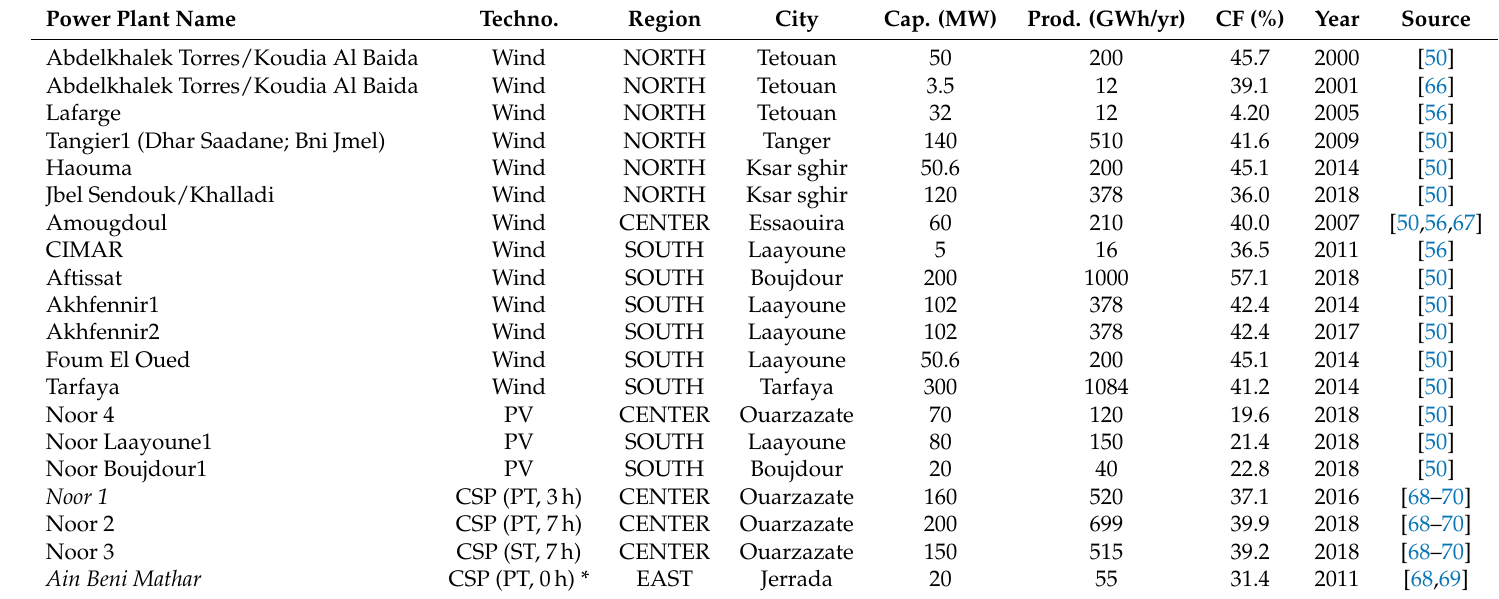
Table A4. Characteristics of the wind, PV and CSP plants from Morocco operational in 2018. PT: Parabolic Trough CSP. ST: Solar Tower CSP. h: expected hours of storage. Based on [64,65], at the end of 2018, the total wind, PV and CSP capacities are 1.22 × 10 3 MW, 170MW and 530MW, respectively. We ignore the production from auto-producers, except for wind plants since their installed capacity is included in the total wind capacity. Data from: MEME [50], RES4MED